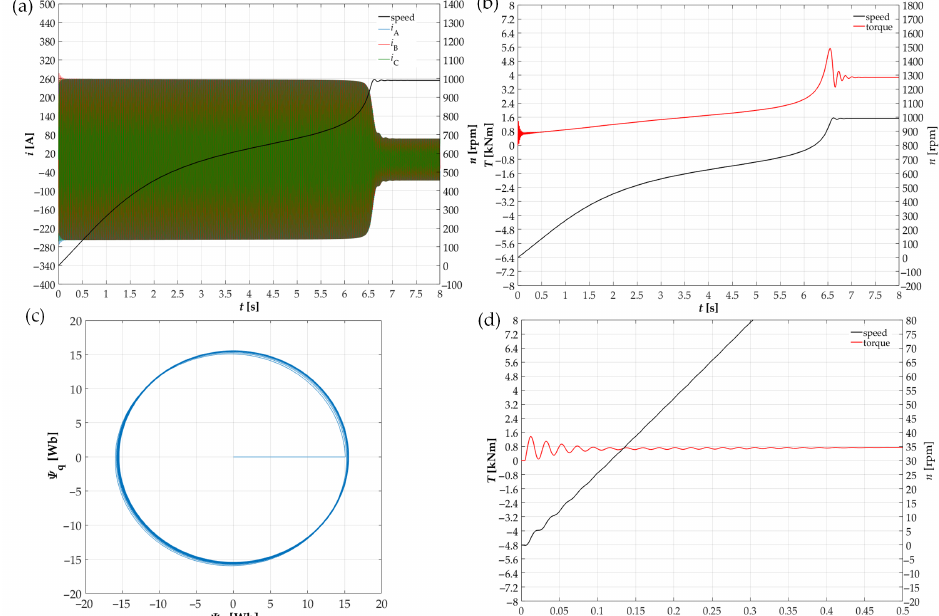
Figure 14. Waveforms of physical quantities for direct starting, with a voltage phase switching delay of t delay = 5 ms and a fan load moment T o = 59 + 3800 rotational speed; ( b ) electromagnetic torque waveform and rotational speed; ( c ) hodograph of stator fluxes; ( d ) fragment of the time waveform of electromagnetic torque and rotational speed, in the first moment of